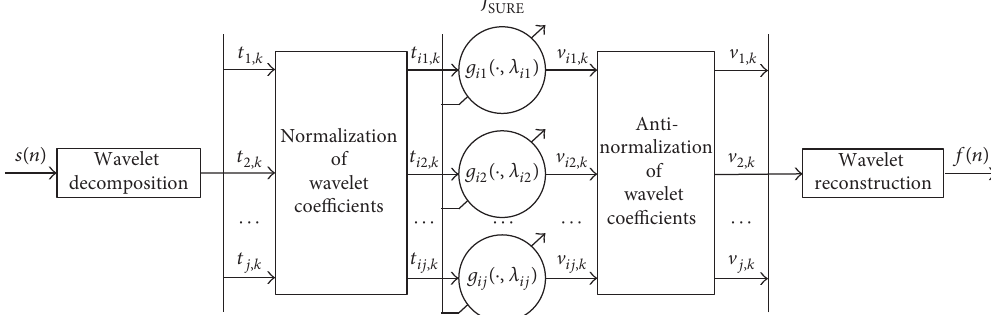
Figure 5: TNN structure of unsupervised learning, where 𝑡 1,𝑘 ,𝑡 2,𝑘 ,...,𝑡 𝑗,𝑘 are the wavelet coefficients obtained from the wavelet decomposition of signal 𝑠(𝑛) , 𝑡 𝑖1,𝑘 , 𝑡 𝑖2,𝑘 ,...,𝑡 𝑖𝑗,𝑘 are the normalized wavelet coefficients, V 𝑖1,𝑘 , V 𝑖2,𝑘 ,..., V 𝑖𝑗,𝑘 are the new normalized wavelet coefficients tuned by thresholding function (11), and the optimal thresholds of thresholding function (11) are selected by (12) and (13), and , V ,..., V V 1,𝑘 2,𝑘 𝑗,𝑘 are the antinormalized wavelet coefficients, which is used for the wavelet reconstruction of signal